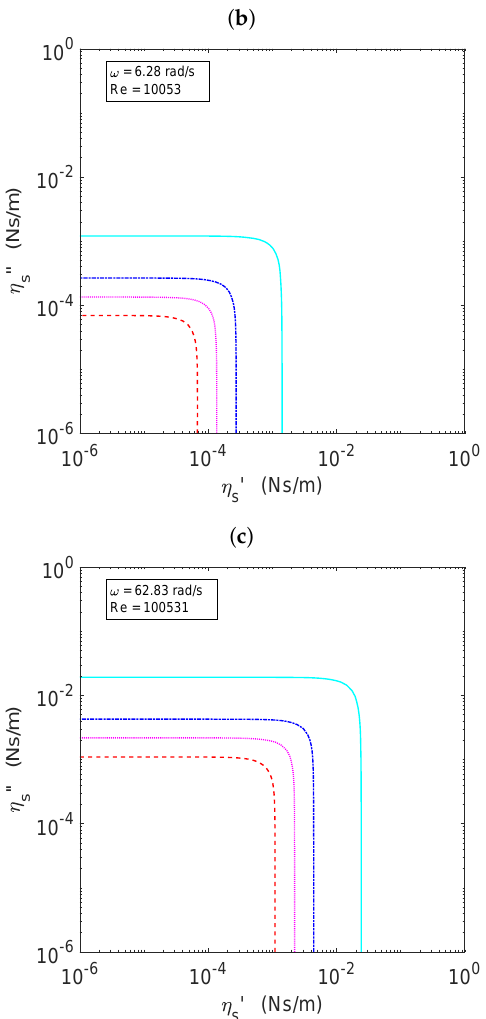
(cid:48)(cid:48) ) in the ( η (cid:48) ) plane at the frequency value indicated in the s , η s prog ) prog